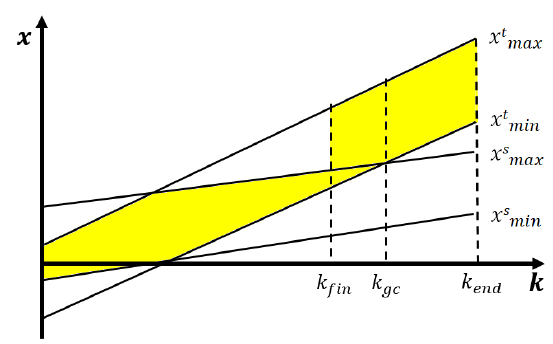
Figure 4. Illustration of position constraint sequence for V H